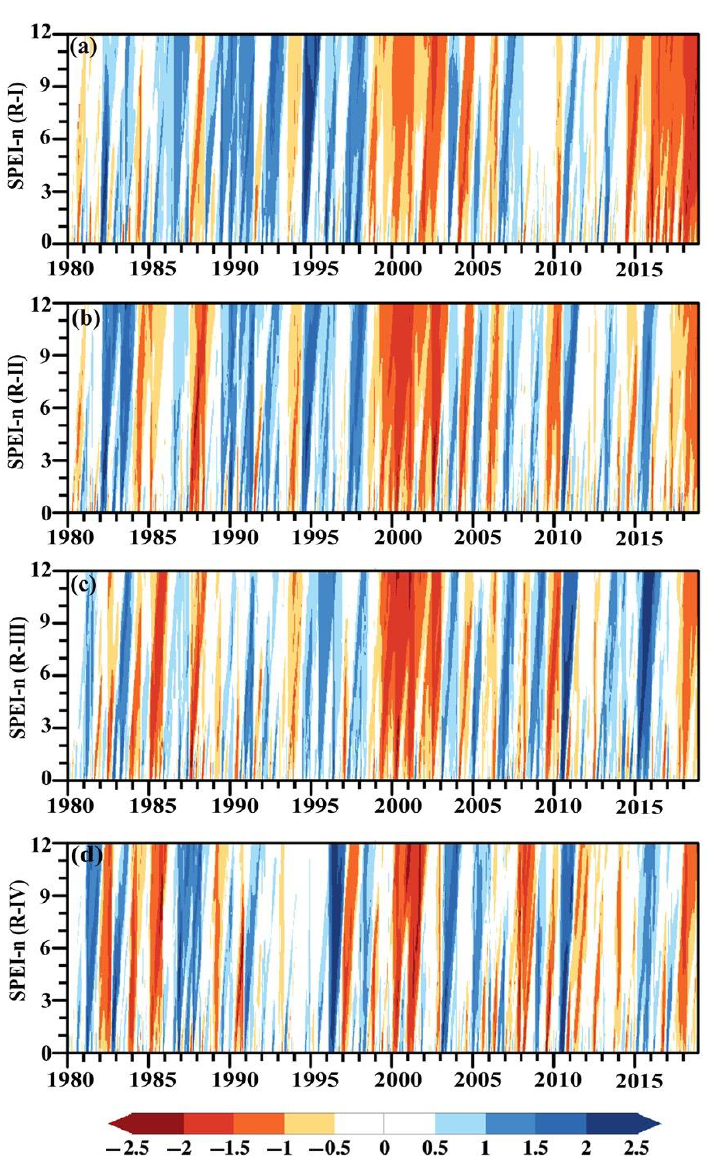
Figure 4. Temporal variation of the SPEI at different timescales (1 to 12 months) for ( a ) R-I, ( b ) R-II, ( c ) R-II, and ( d ) R-IV from 1985 to 2015. The R-I, R-II, R-III, and R-IV represent the hyper-arid, arid, humid, and glacial regions, respectively. The SPEI-n below − 1 (or greater than 1) is selected as a threshold level for the drought (or wet) event.